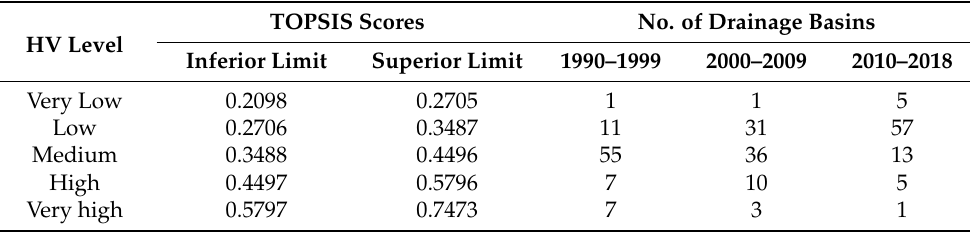
Table 5. The HV classes and their assigned number of drainage basins in